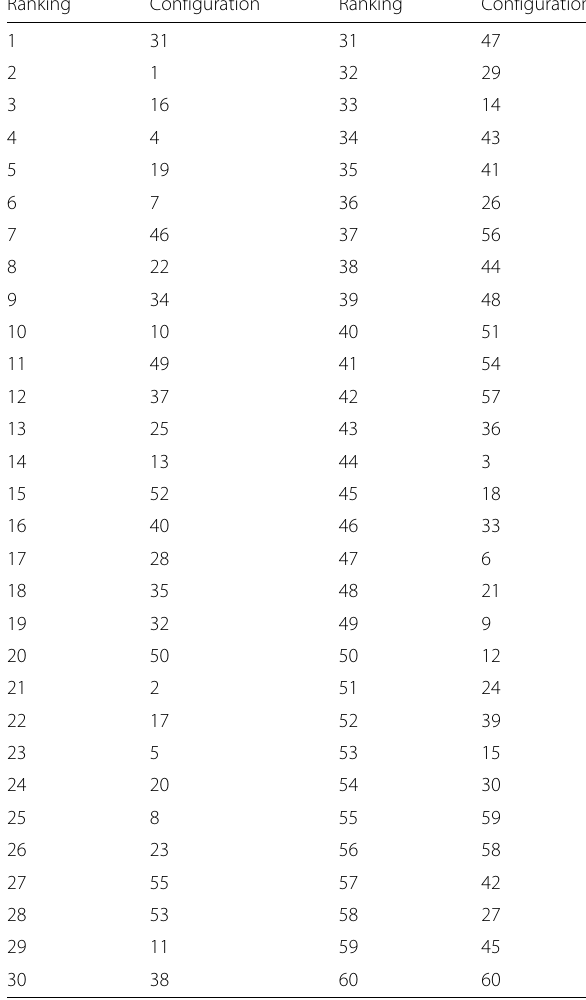
Table 16 Configuration ranking for the defined criteria (i.e. maximize COA and minimize cost)